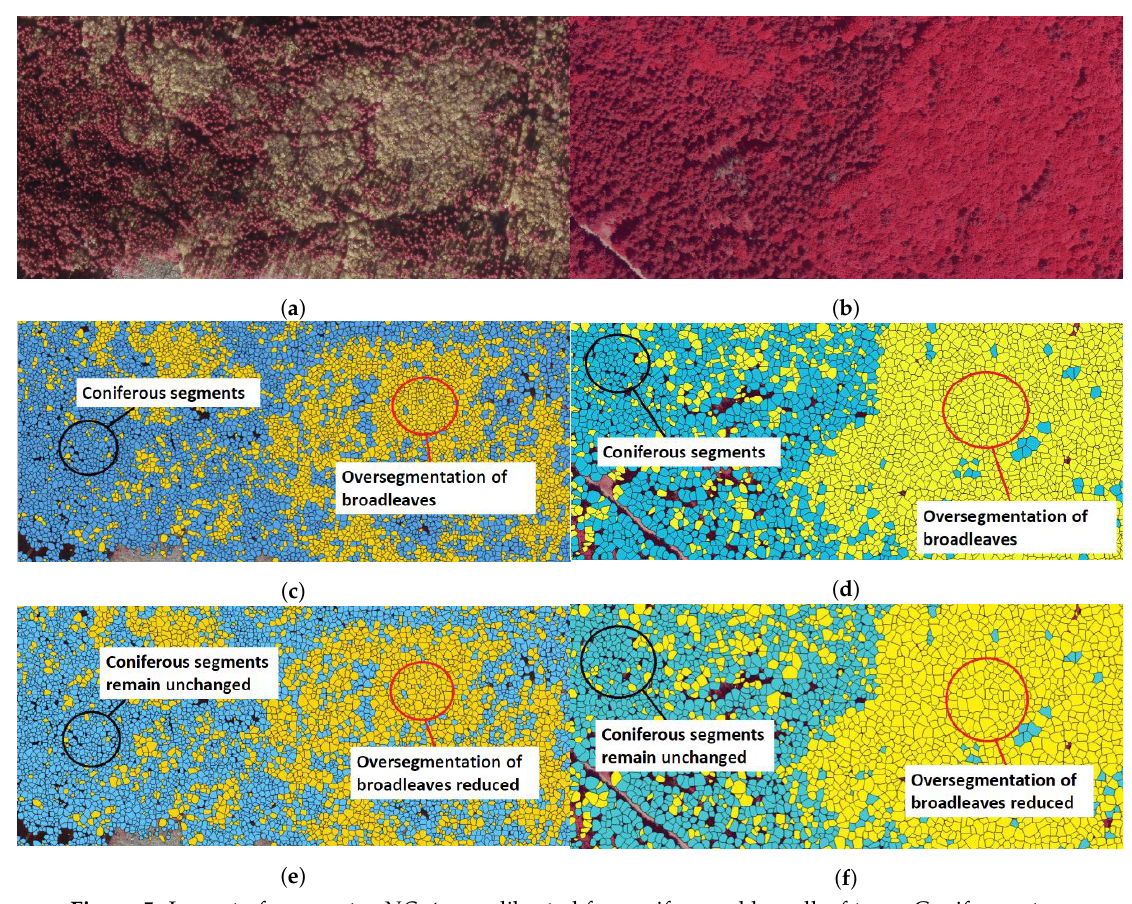
Figure 5. Impact of parameter NCut max calibrated for conifers and broadleaf trees. Coniferous tree segments are in blue; broadleaf tree segments are in yellow. ( a ) Cut-out of aerial image in forest area of Šumava National Park. Approximate location is 48 ◦ 47 (cid:48) 57 (cid:48)(cid:48) N, 13 ◦ 51 (cid:48) 27 (cid:48)(cid:48) E. Approximate size is 655 m × 310 m. ( b ) Cut-out of aerial image in forest area of Bavarian Forest National Park. Approximate location is 48 ◦ 55 (cid:48) 45 (cid:48)(cid:48) N, 13 ◦ 20 (cid:48) 15 (cid:48)(cid:48) E. Approximate size is 456 m × 216 m. ( c ) Tree segments in area ( a ) NCut max = 0.16. ( d ) Tree segments in area ( b ) NCut max = 0.16. ( e ) Tree segments in area ( a ) NCut max = 0.10. ( f ) Tree segments in area ( b ) NCut max =